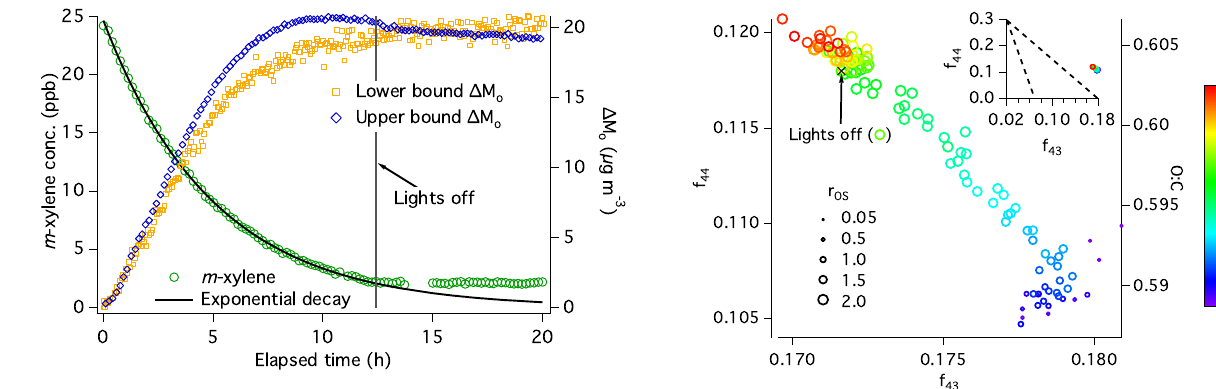
ation was stopped after 12.4h, corresponding to the peak of 1M o . This point is denoted by the “x”. Marker size denotes the organic- to-sulfate ratio, r OS , of suspended particles. After irradiation stops, the chemical composition of the SOA does not change significantly. The inset shows the position of the data with respect to the trian- gular region characteristic of ambient SOA bounded by the dashed lines, as defined by Ng et al.